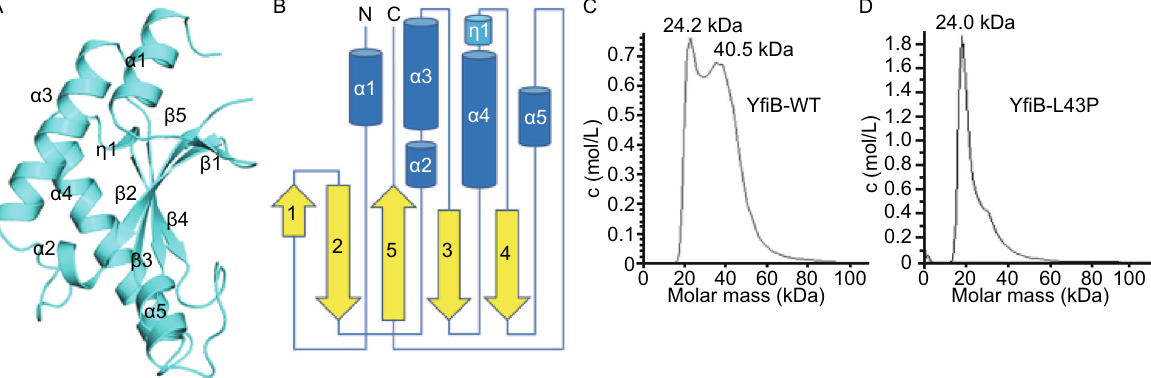
Figure 1. Overall structure of Y fi B. (A) The overall structure of the Y fi B monomer. (B) A topology diagram of the Y fi B monomer. (C and D) The analytical ultracentrifugation experiment results for the wild-type Y fi B and Y fi B L43P .